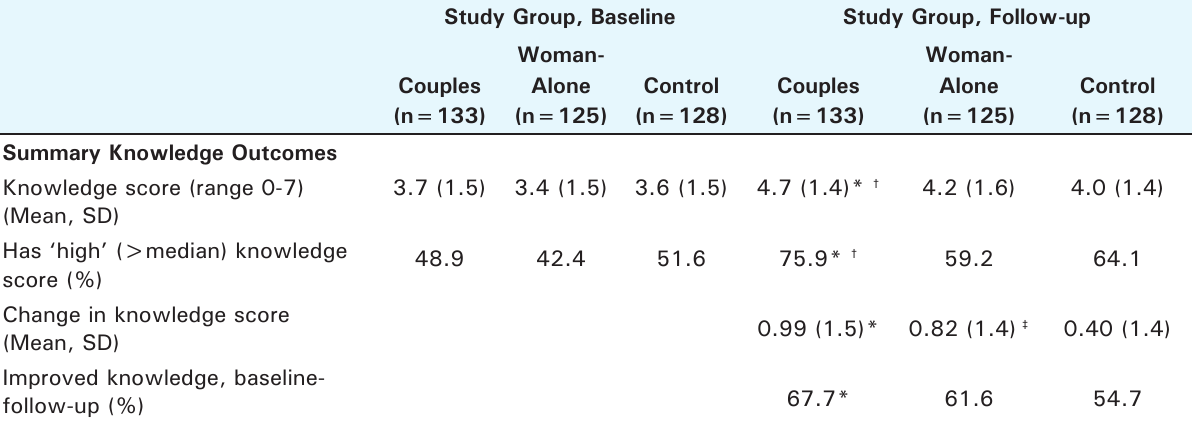
table 1. Percentage distribution of unadjusted knowledge outcomes and comparison between randomized groups at baseline and at follow-up